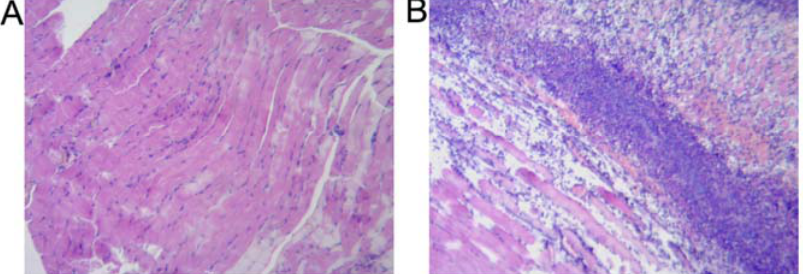
Figure 3. Microscopic observation of the three days’ inoculated right thigh inflammatory tissue ( B ) and the left thigh normal tissue ( A ). Microscopically, there were many inflammatory cells infiltrating among striated muscle in the HE staining ( B ), and the normal striated muscle tissue was also displayed ( A ) (all specimens were stained by hematoxylin and eosin and magnified by